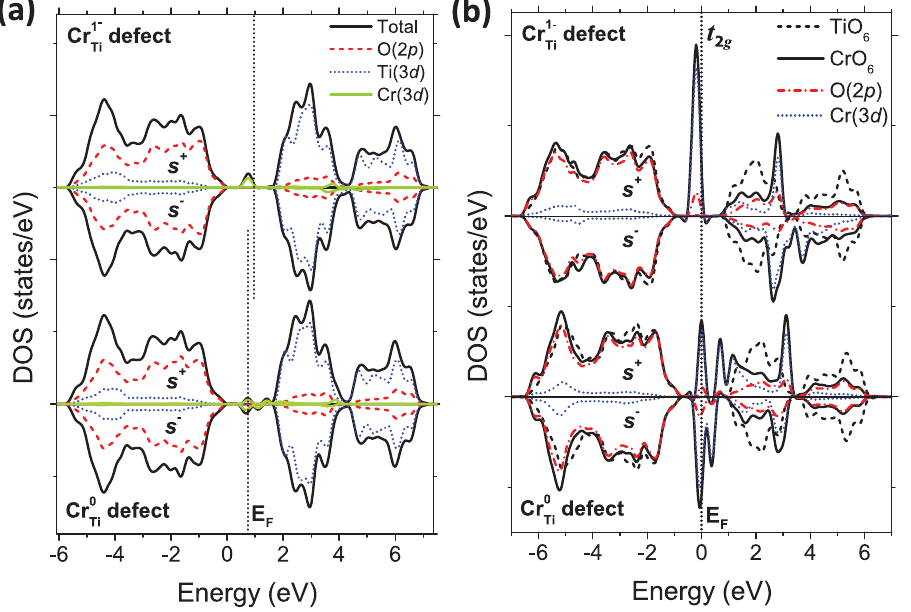
Figure 4. ( a ) Spin polarized ( s + , s − ) total DOS and pDOS corresponding to O(2 p ), Ti(3 d ) and Cr(3 d ) states for Cr Ti1 − and Cr Ti0 defects, and ( b ) DOS contributions from CrO 6 and TiO 6 (dashed) octahedra.